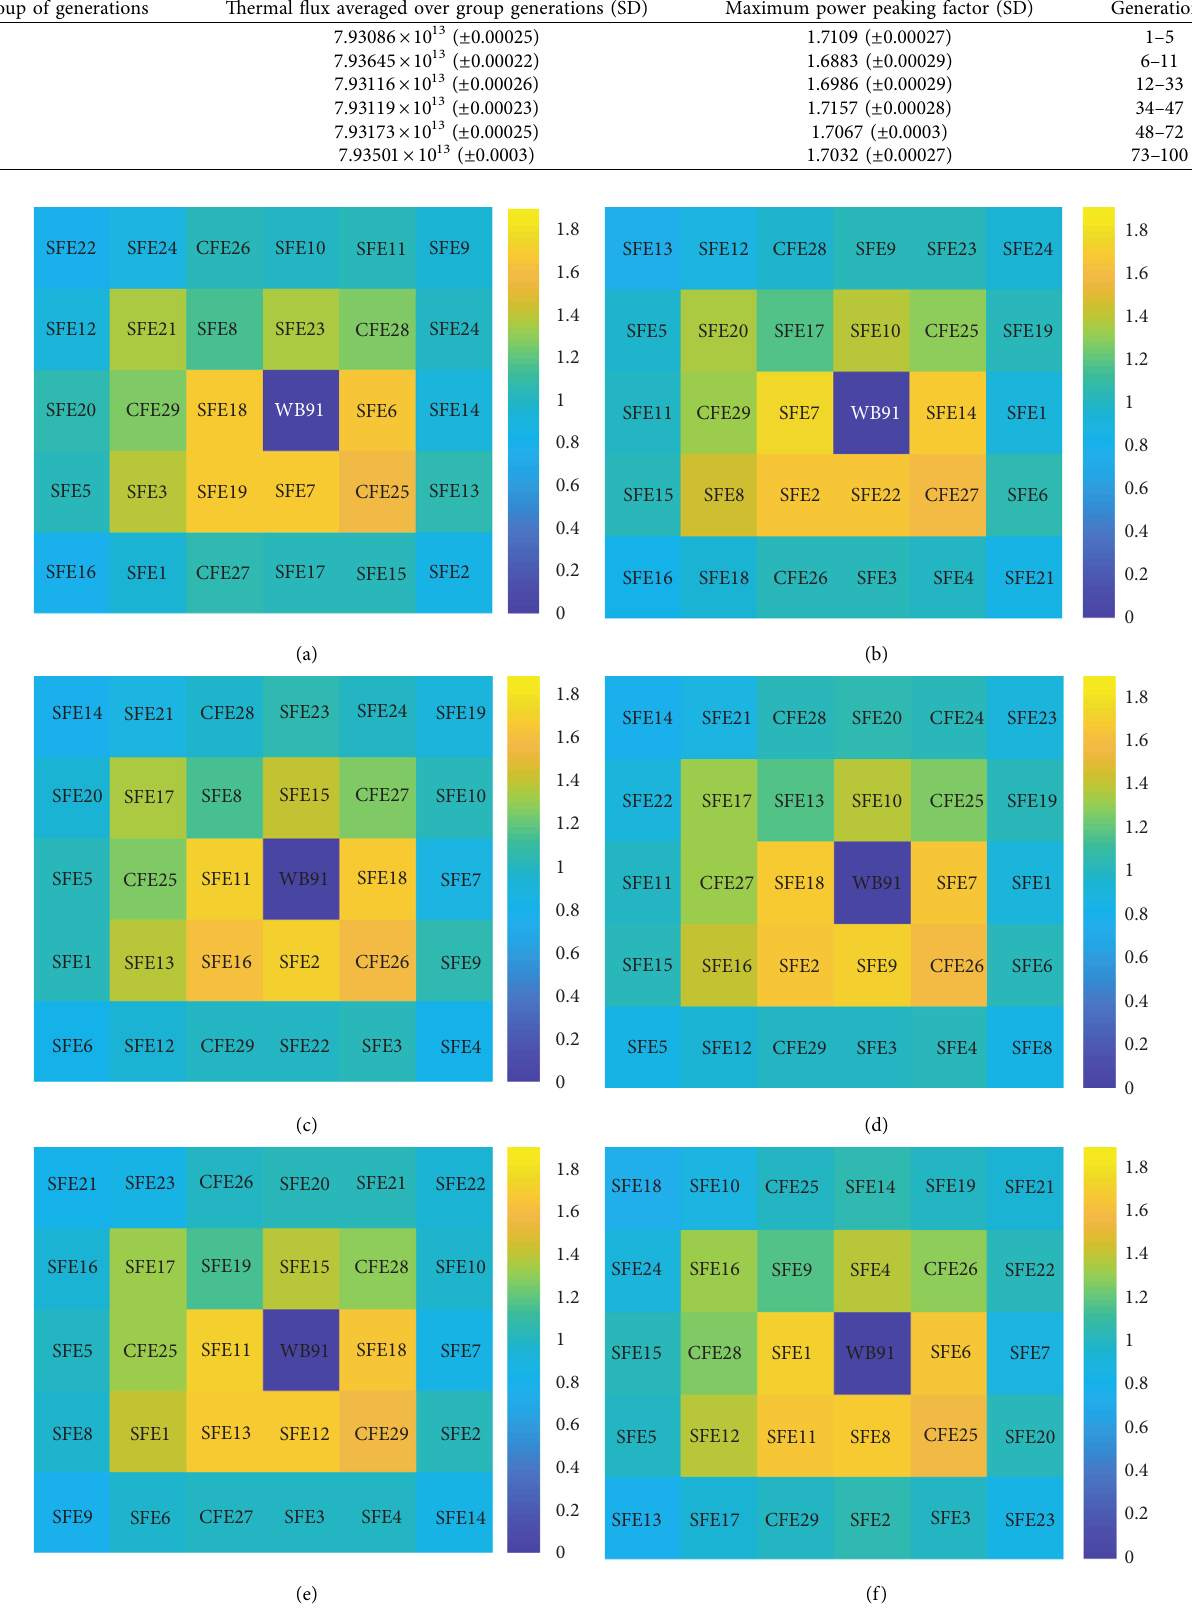
Figure 9: Optimal loading patterns for the group generations having the same k k eff � 1.038351 ( ± 0.00023). (c) Group 3: k eff � 1.039018 ( ± 0.00027). (d) Group 4: k eff � 1.038775 ( ± 0.00025). (e) Group 5: k eff � 1.038907 ( ± 0.00024). (f) Group 6: k eff � 1.038659 ( ±